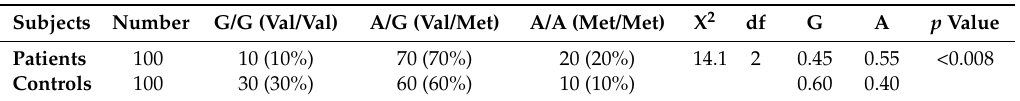
Table 4. Genotype and allele frequency of COMT polymorphism in coronary artery disease (CAD) patients and